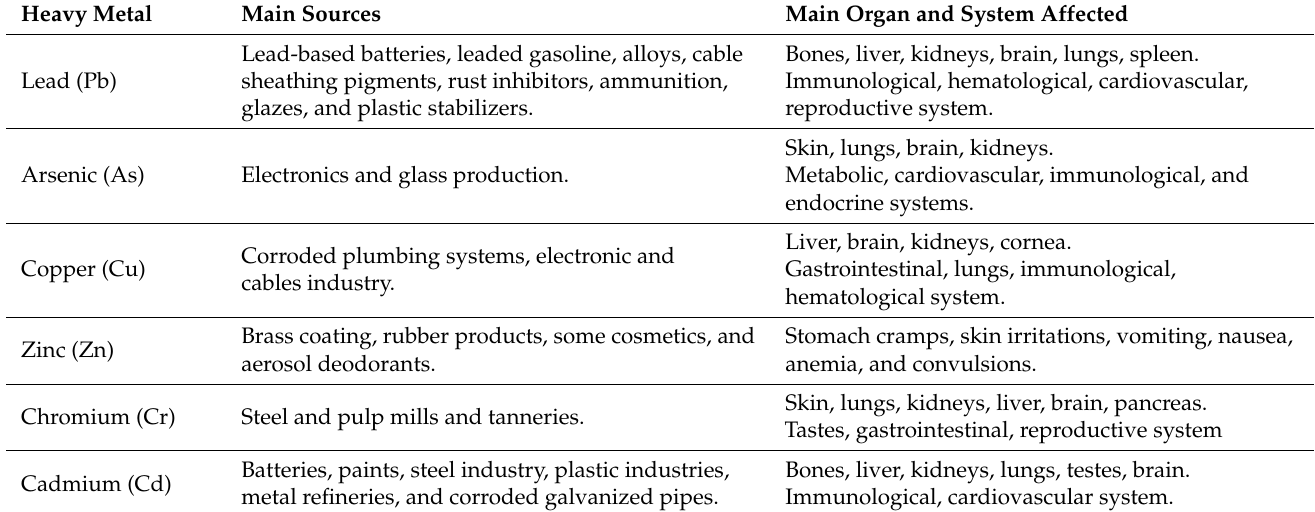
Table 2. Common heavy metals found in wastewater, their origins, and the health problems they cause